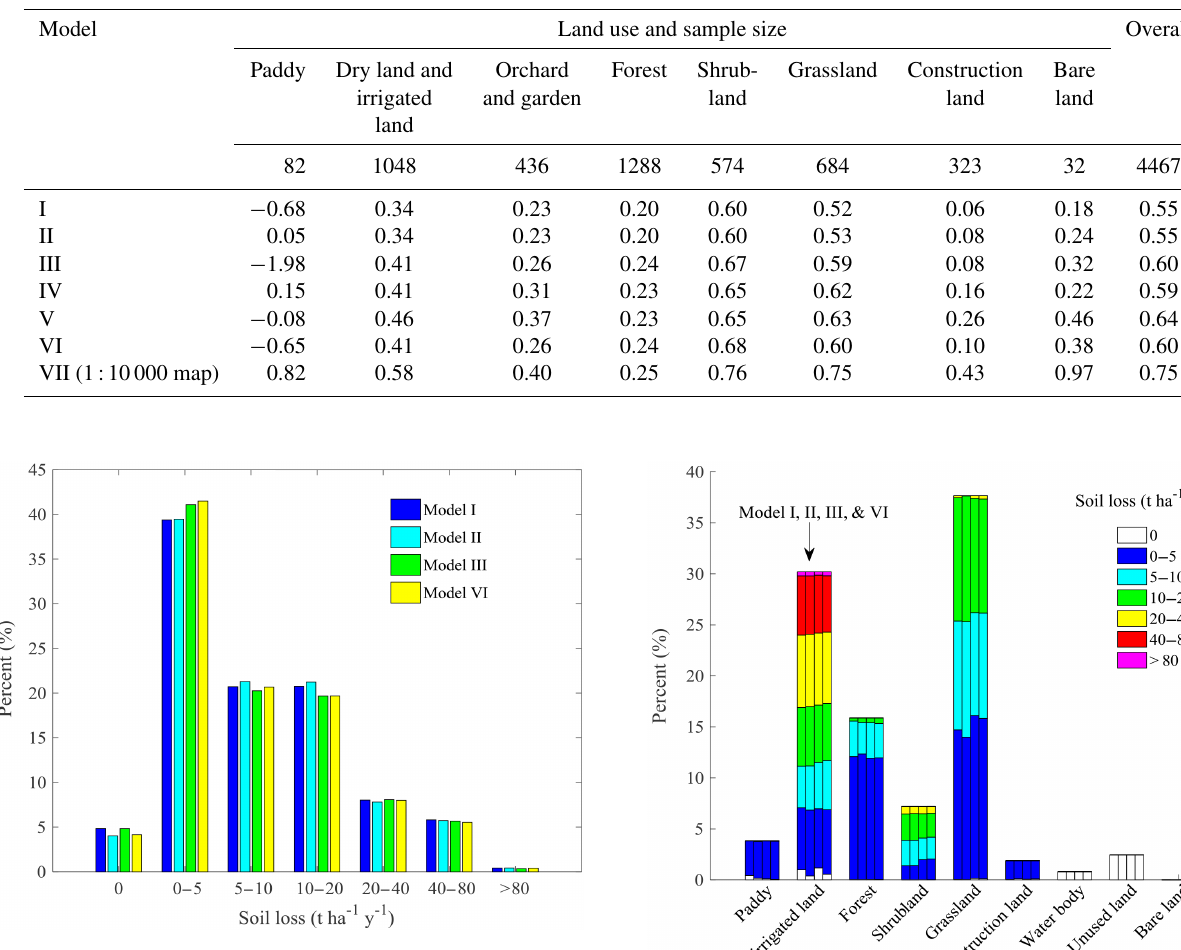
Figure 7. Proportion of soil erosion intensity levels for four models including Model I–VI. Table 3. Soil loss rates (tha − 1 yr − 1 ) for farmland, forest, shrubland, and grassland by Model VI in this study and in the northwest region of China from Guo et al. (2015).